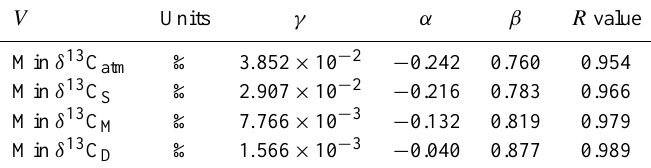
Table 5. Power law scalings for modern configuration, δ 13 C variables, (cid:49)V = γD α E β . D in [yr] and E in [PgC]. V